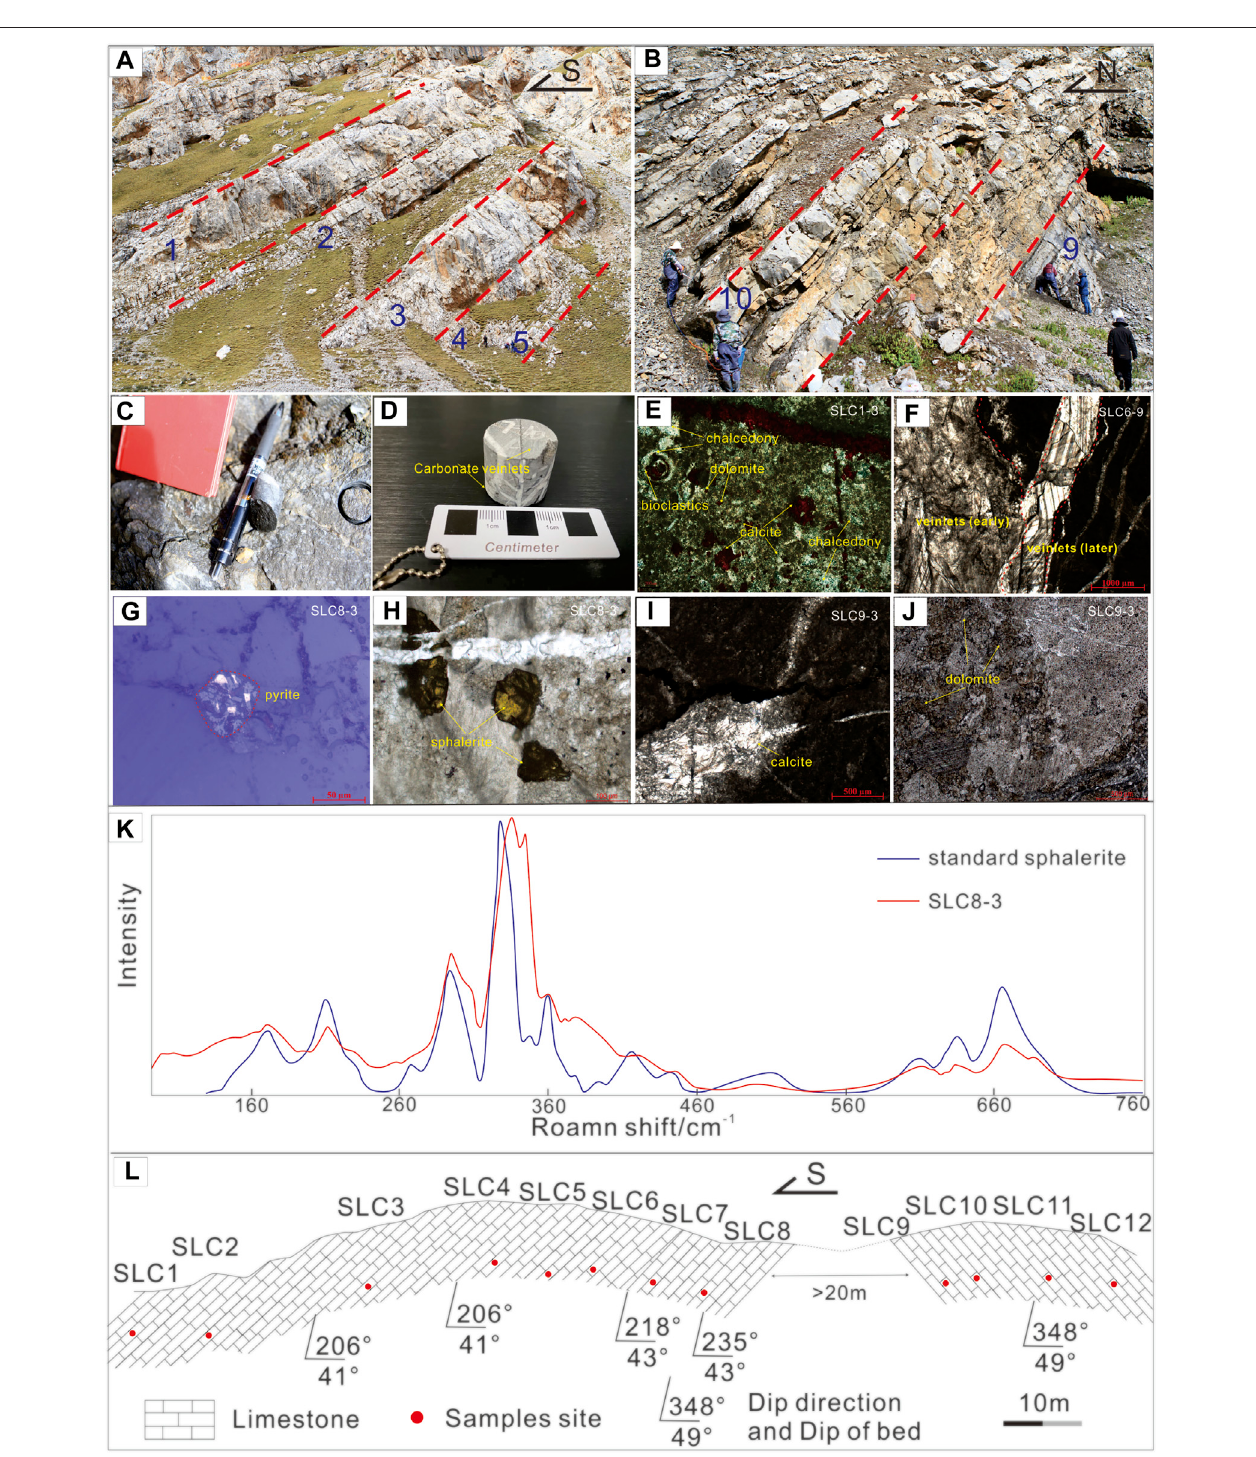
FIGURE 2 | Study section (A – D) Field photographs of the Upper limestone ZD Formation (E – J) Photomicrograph (e: cross-polarized light; g: re fl ected light; f, h, i, and j: single-polarized light and plane-polarized light) of the representative samples from the Upper limestone ZD Formation (K) Raman spectrum of sample SLC8-3 (L) Cross section showing the paleomagnetic sampling sites (red dots) in the Sulucun section.